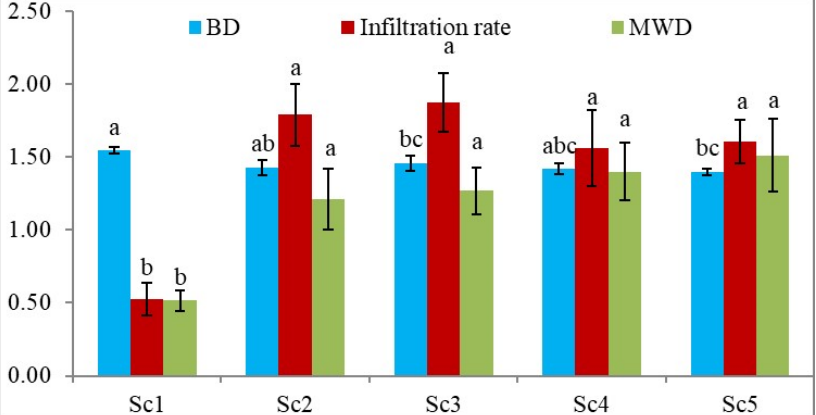
Figure 1. Bulk density (BD, Mg m − 3 ), infiltration rate (mm h − 1 ), and mean weight diameter (MWD, mm)